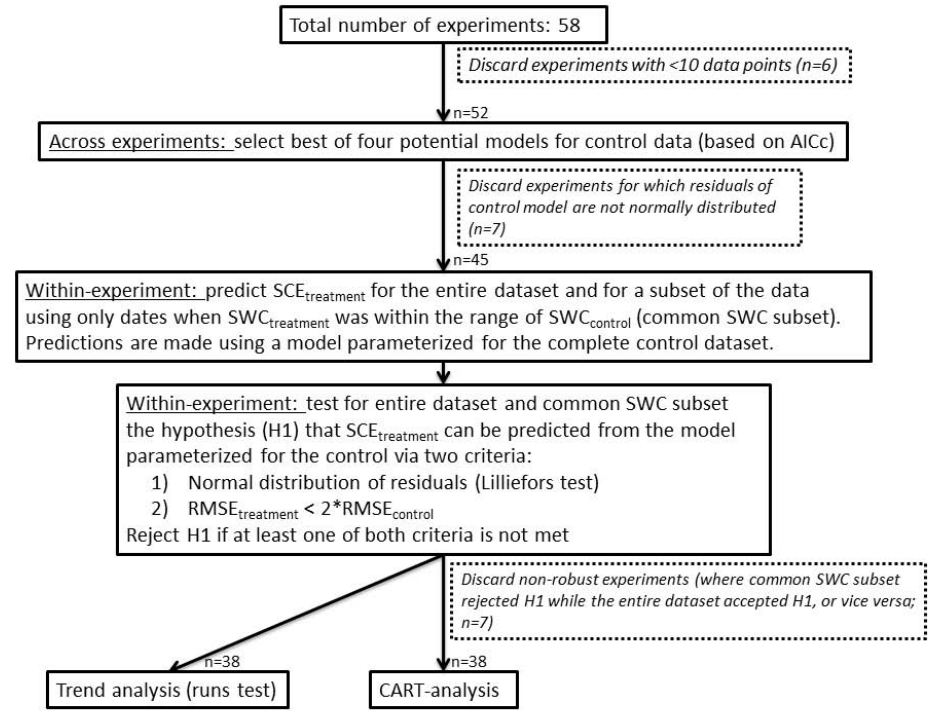
Figure 1. (a) Overview of the magnitude and direction of precipitation effect on soil CO 2 efflux (SCE) for the different experiments. Arrows point from control precipitation to treatment precipitation (averaged over different years in case of multi-year data). Crosses localize control conditions in terms of annual precipitation and mean annual temperature (MAT). Black arrows indicate a positive correlation between precip- itation manipulation and SCE, i.e., an increase of SCE when precipitation increases, or a decrease of SCE when precipitation is reduced. Gray arrows indicate negative correlations (which could be considered to reflect somewhat unexpected results). Bold arrows represent significant differences between SCE treatment and SCE control ( p < 0 . 05), while thin arrows reflect non-significant differences (repeated measures ANOVA). Panel (b) shows the biomes that are represented by our data set (biome figure adapted from Chapin et al.,